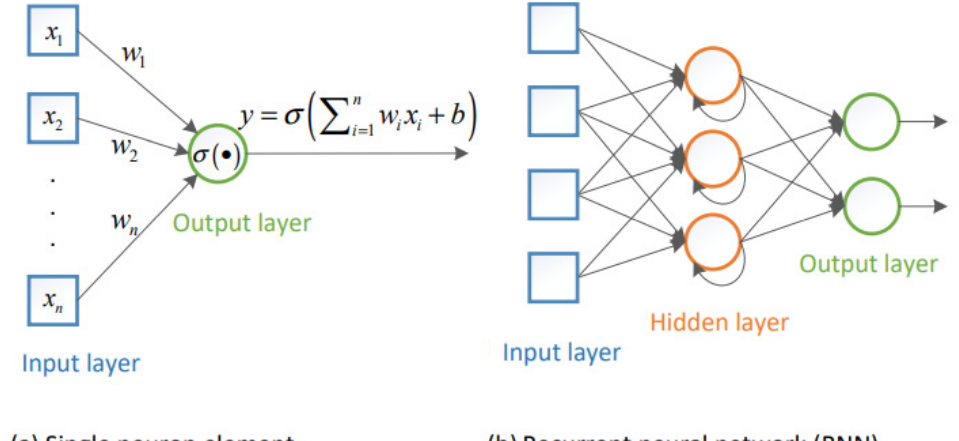
Figure 1. RNN network architecture.